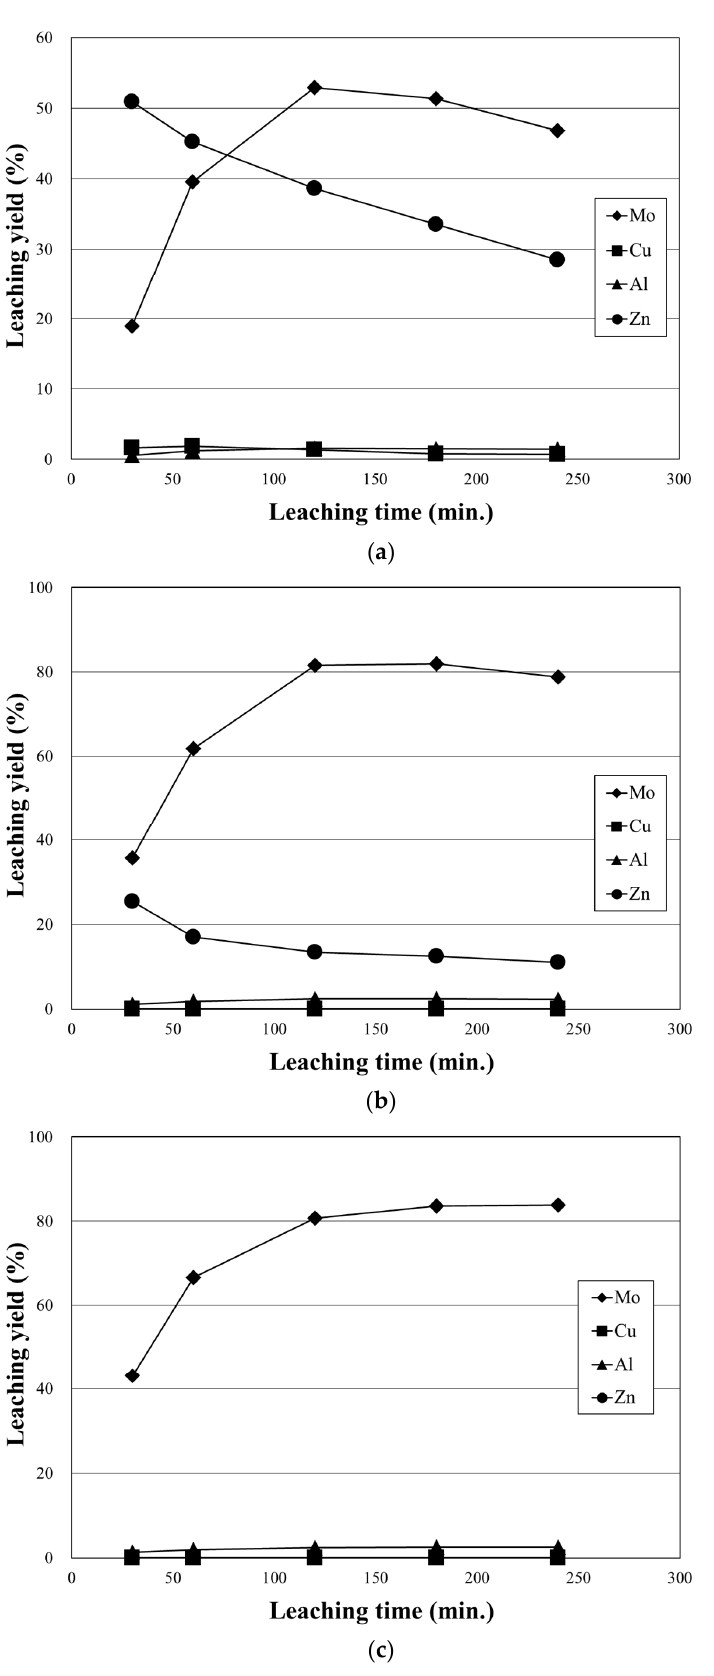
Figure 2. Leaching yields of metal ions with time at various pHs. ( a ) pH5 ( b ) pH7 ( c )